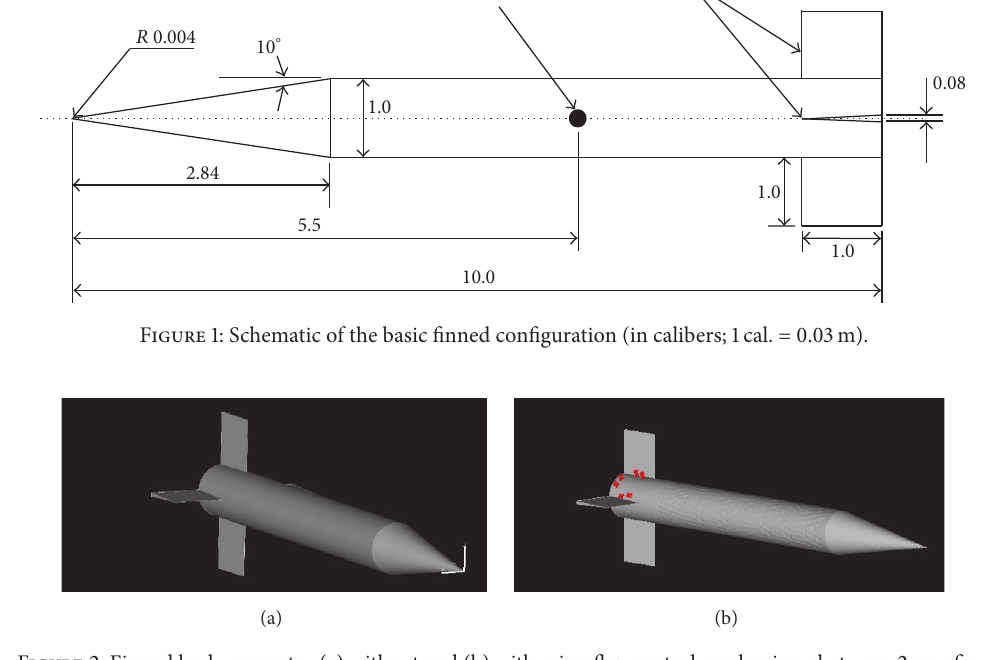
Figure 2: Finned body geometry (a) without and (b) with microflap control mechanisms between 2 rear fins.